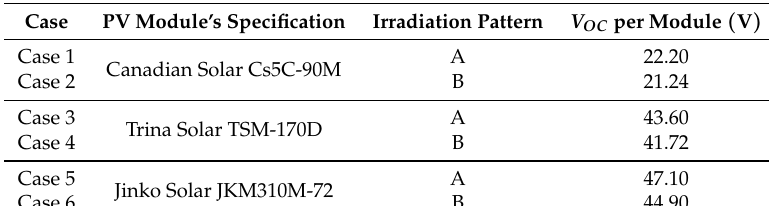
Table 1. Summarized information of example cases.